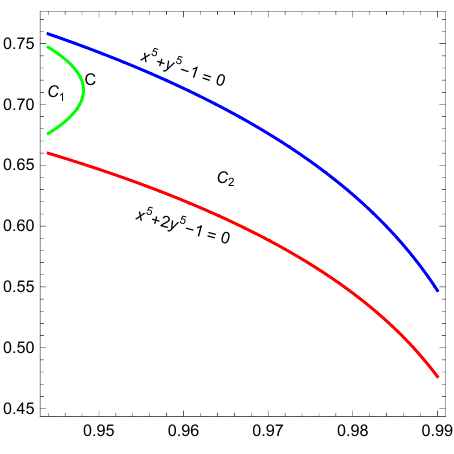
Figure 3. Regions C 1 , C 2